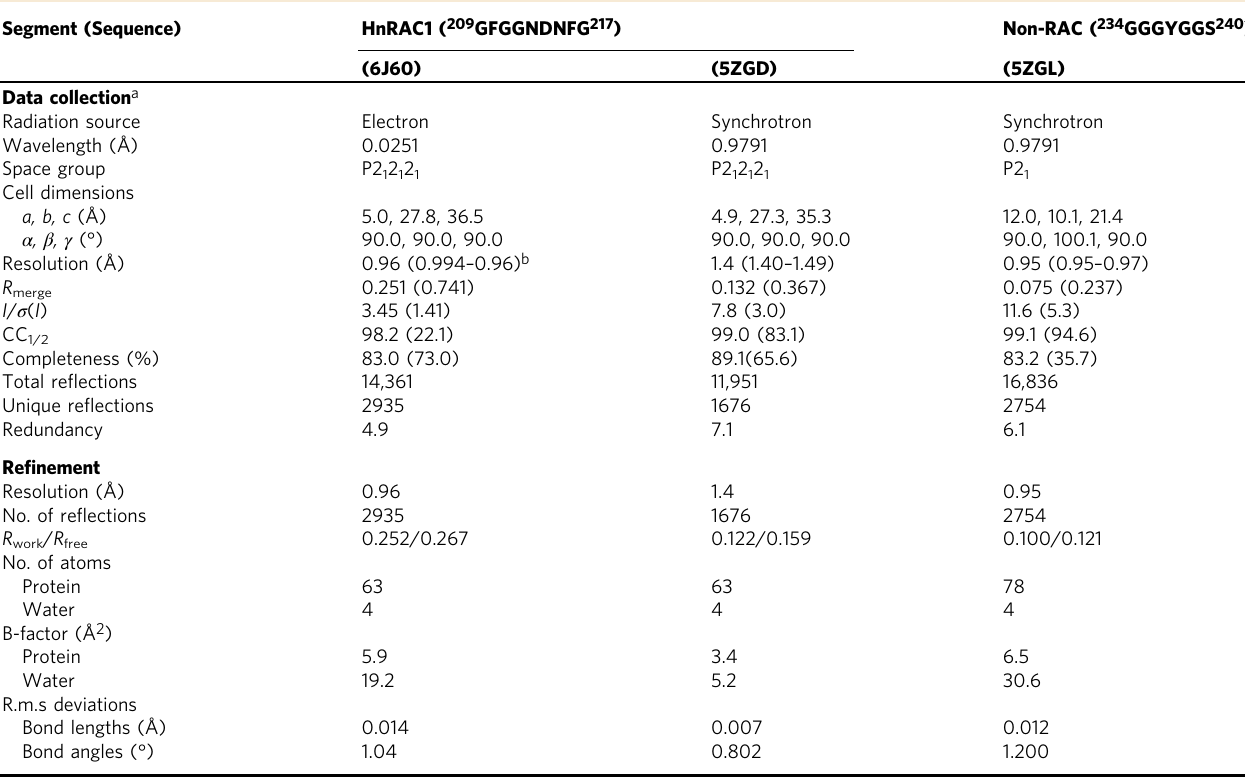
Table 1 Statistics of crystallographic data collection and atomic re fi nement of hnRNPA1 segments Segment